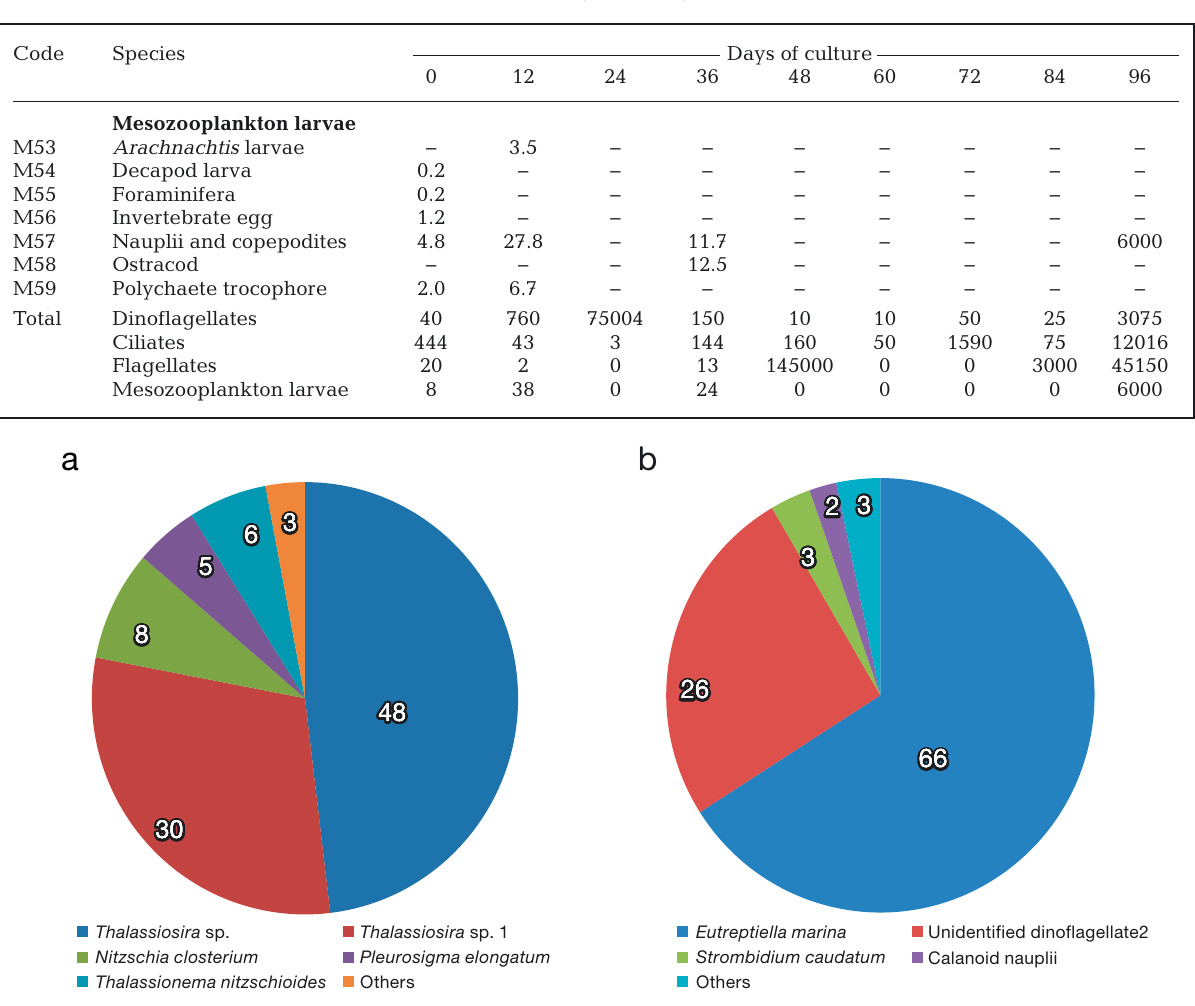
Fig. 4. Relative percent contribution of (a) phytoplankton and (b) microzooplankton species during the culture of Litopenaeus vannamei